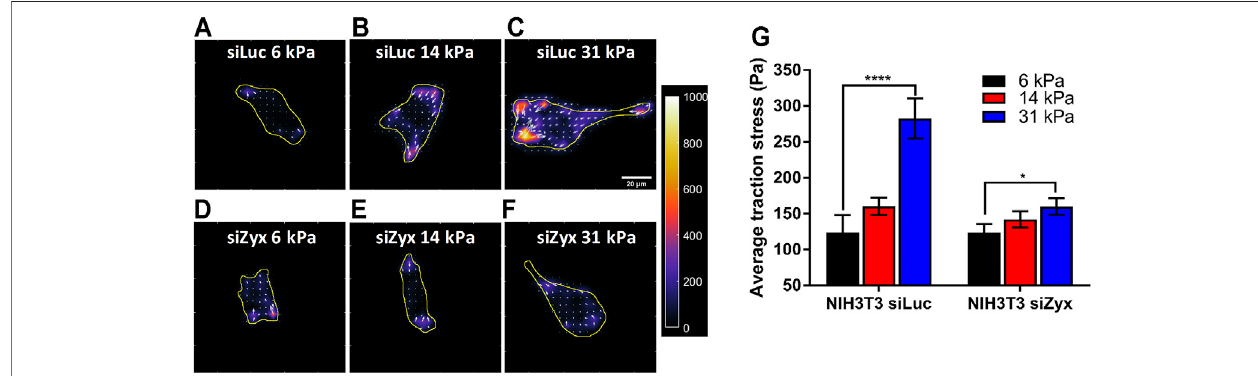
FIGURE 3 | Zyxin-knockdown NIH3T3 cells do not increase cell traction stress in response to increasing substrate rigidity (A – F) Traction stress maps of (A – C) siLuc-NIH3T3 cells and (D – F) siZyx-NIH3T3 cells on substrates of rigidity 6 kPa, 14 and 31 kPa. Arrows denote the direction and magnitude of the traction stress in the x- and y-directions (G) Average traction stressmagnitudes ofsiLuc- and siZyx- NIH3T3 cells on substrates of rigidity 6,14, and 31 kPa, n (cid:2) 11,22, 19for siLuc-NIH3T3 6 kPa, 14 and 31 kPa, respectively. n (cid:2) 17, 25, 12 for siZyx-NIH3T3 6 kPa, 14 and 31 kPa, respectively. Error bars represent standard error of the mean. **** represents p < 0.001 and * represents p < 0.05.